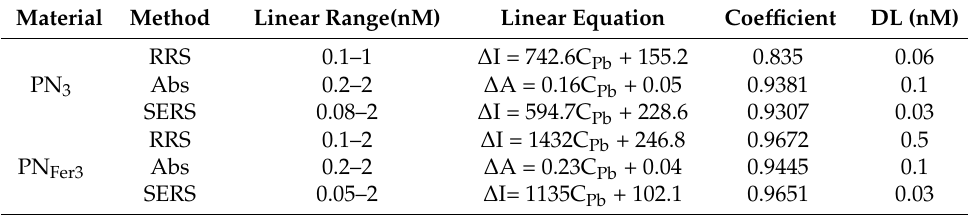
Table 1. Analytical characteristics of Pb 2+ determination with different nanozymes.